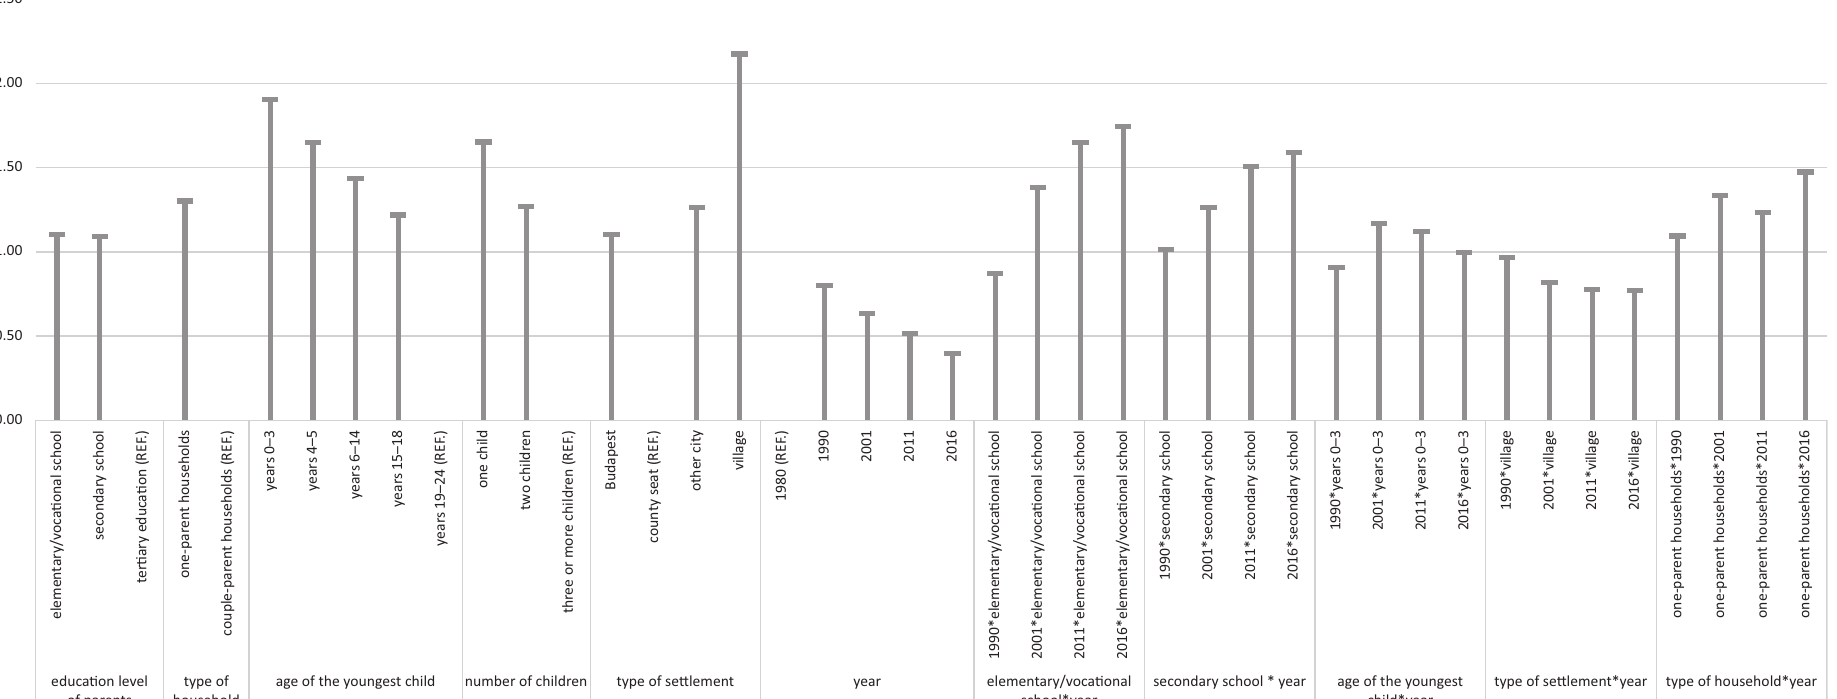
Social Inclusion, 2023, Volume 11, Issue 1, Pages